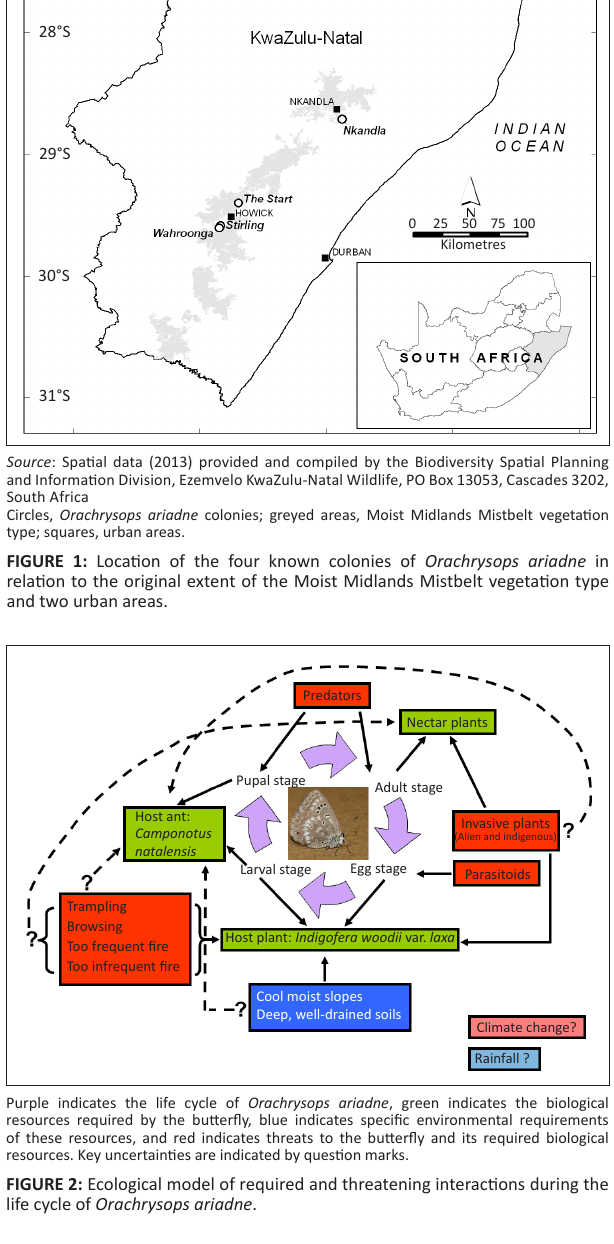
FIGURE 2: Ecological model of required and threatening interactions during the life cycle of Orachrysops ariadne .